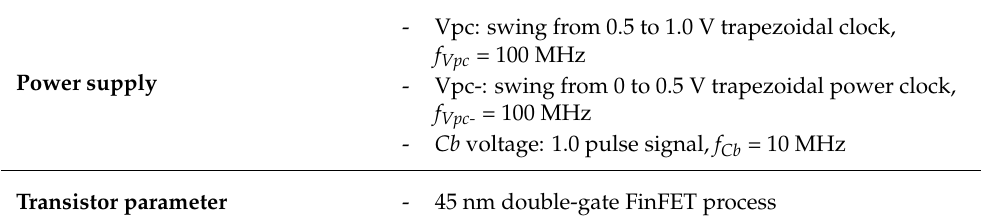
Figure 6. 4-bits LSI circuit Monte-Carlo simulation result: ( a ) proposed FinFET-based TPCA-PUF and ( b ) FinFET-based QUALPUF.